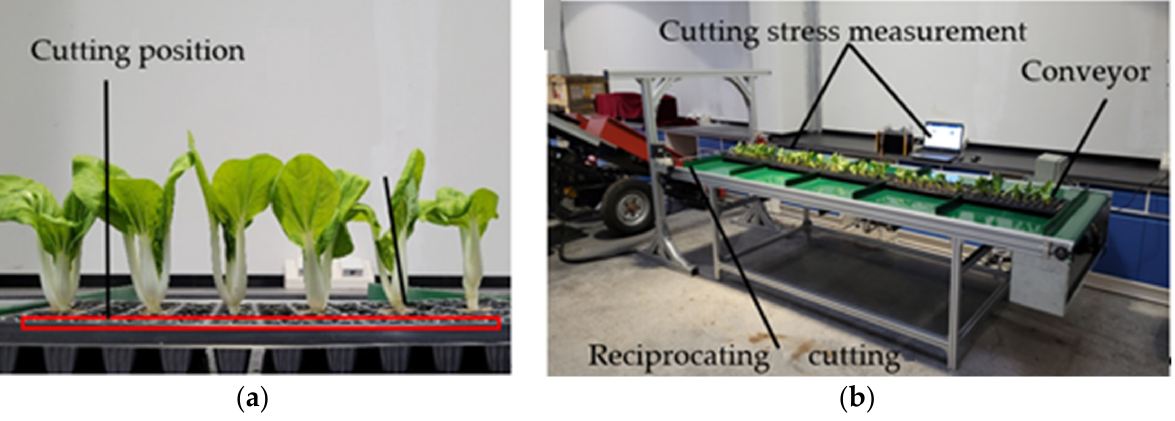
Figure 5. Schematic diagram of measurement system of cutting stress: ( a ) test sample; ( b ) cutting stress measurement system.